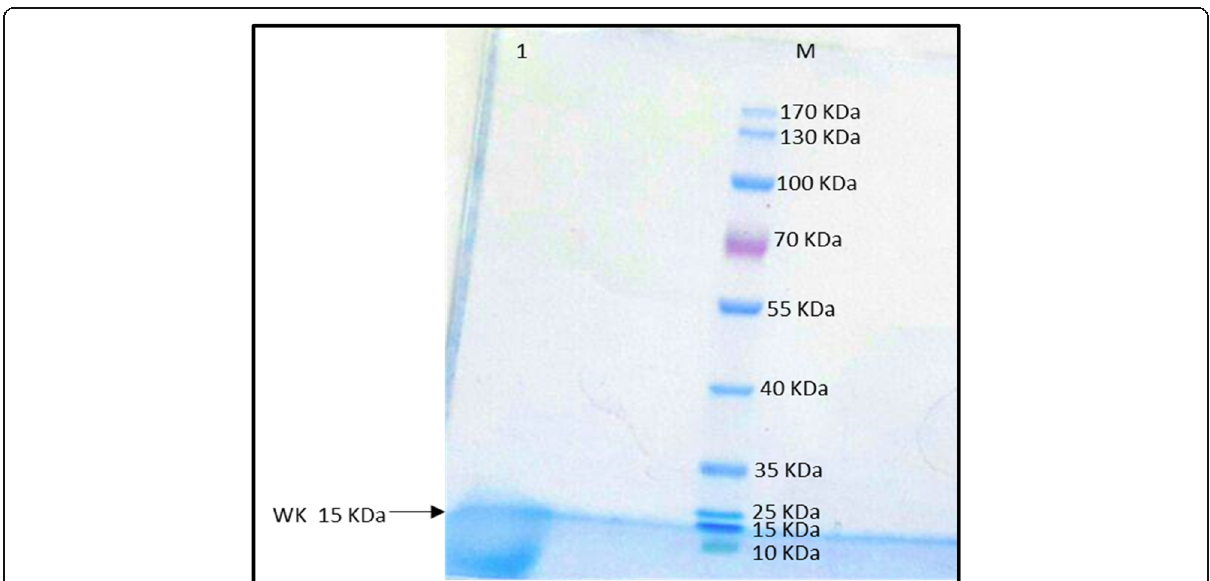
Fig. 4 Commassie blue stained SDS-PAGE profile of total proteins purified (WK) for Wickerhamomyces anomalus by ion exchange chromatography using L-H sephadex M: Marker protein lane 1 WK (15 KDa) band